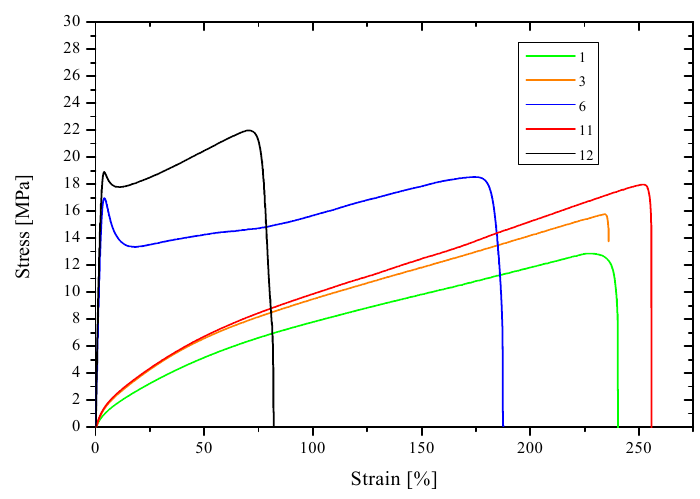
Figure 5. Examples of extension curves for the test membranes. The composition of membranes is given in Tables 2 and 3.